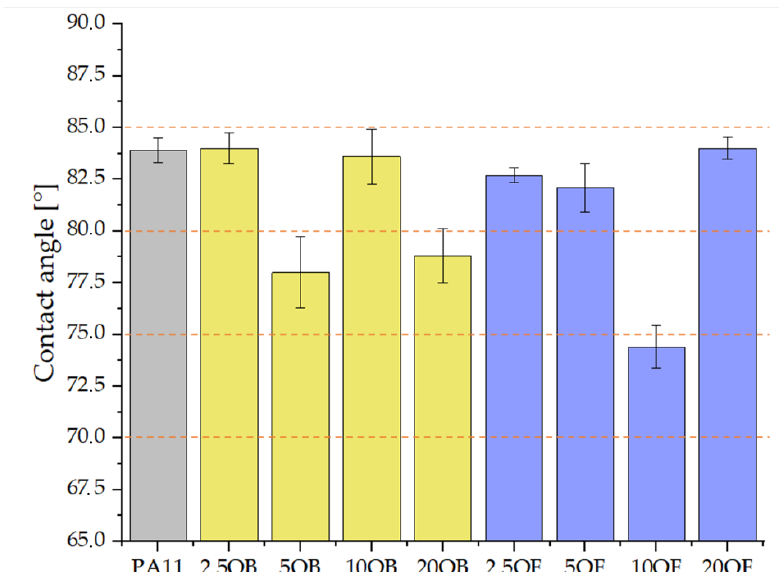
Figure 15. Contact angles of biocomposites’ surfaces.